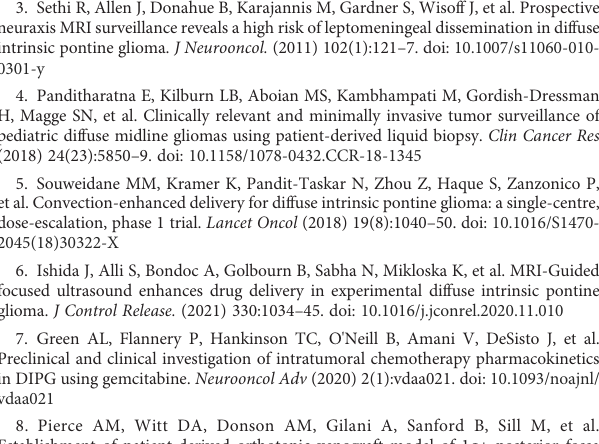
SUPPLEMENTARY FIGURE 1 (A) Screenshot from SmART-ATP treatment planning software showing dose distribution for focal irradiation. Approximate tumor location is shown in green; (B) Dose-volume histogram for spine, brain, and pons, based on simulated focal irradiation; (C) Illustration of the two pairs of opposing lateral beams used for CSI on the fl uoroscopy image on an x-ray image of a mouse on the custom platform; (D) Simulated dose distribution for opposing lateral beams through the spine, showing roughly uniform dose for all soft tissue in the fi eld. Note that the distribution simulated for spinal irradiation is not for the exact collimator used to treat these mice; a dose-rate correction factor for the custom collimator based on Gafchromic fi lm dosimetry was used to determine the appropriate beam times from the simulation. SUPPLEMENTARY FIGURE 2 (A) Example images showing metastatic deposits in various areas of the brain on histopathology, with an axial MRI showing correlating leptomeningeal metastases from the same mouse; (B) Example images showing metastatic tumor at different levels of the spine on sagittal